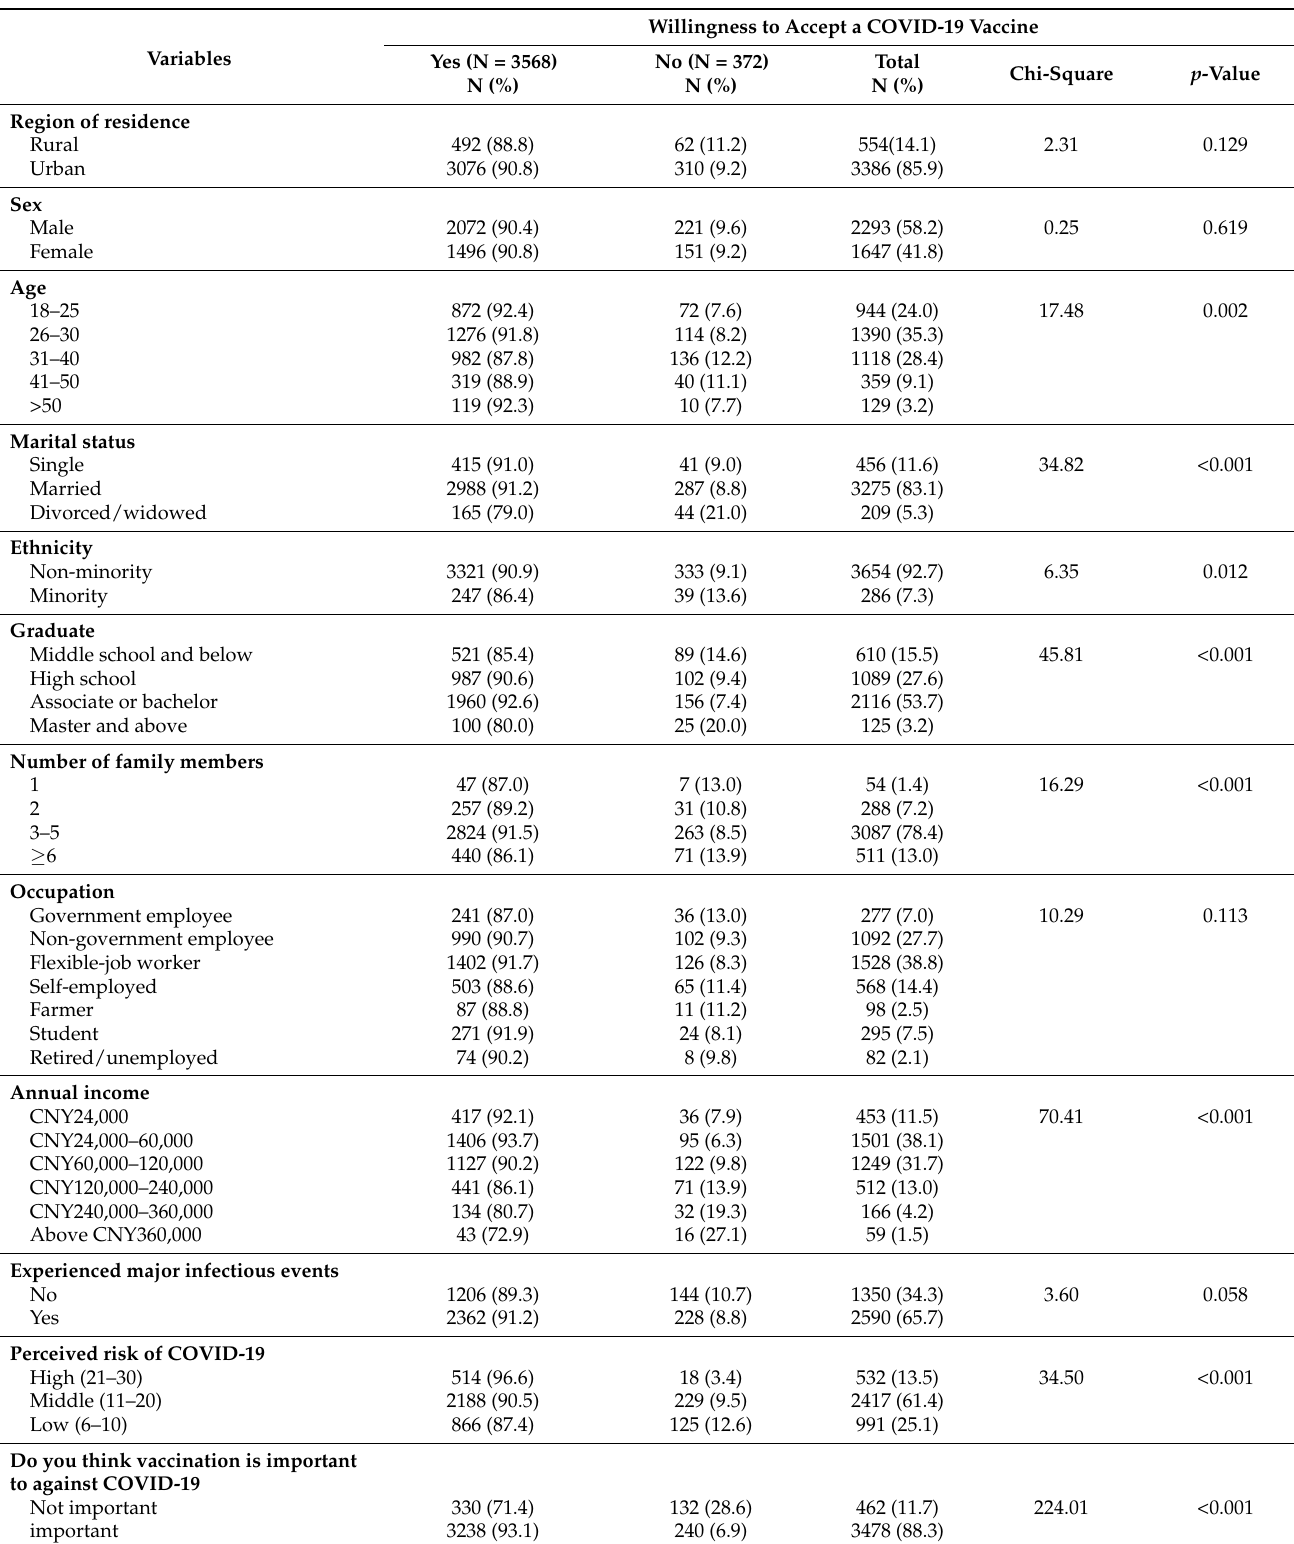
Table 2. Frequency distribution and chi-square analysis of COVID-19 vaccine